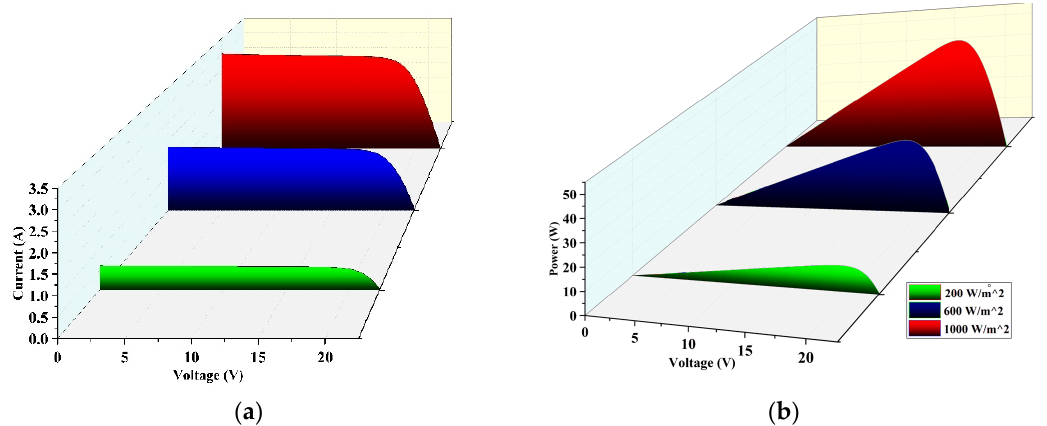
Figure 18. Uniform pattern (STC) tested with the proposed modified LFO algorithm ( a ) I-V ( b ) P-V at 1000 W/m 2 , 600 W/m 2 , and 200 W/m 2 .